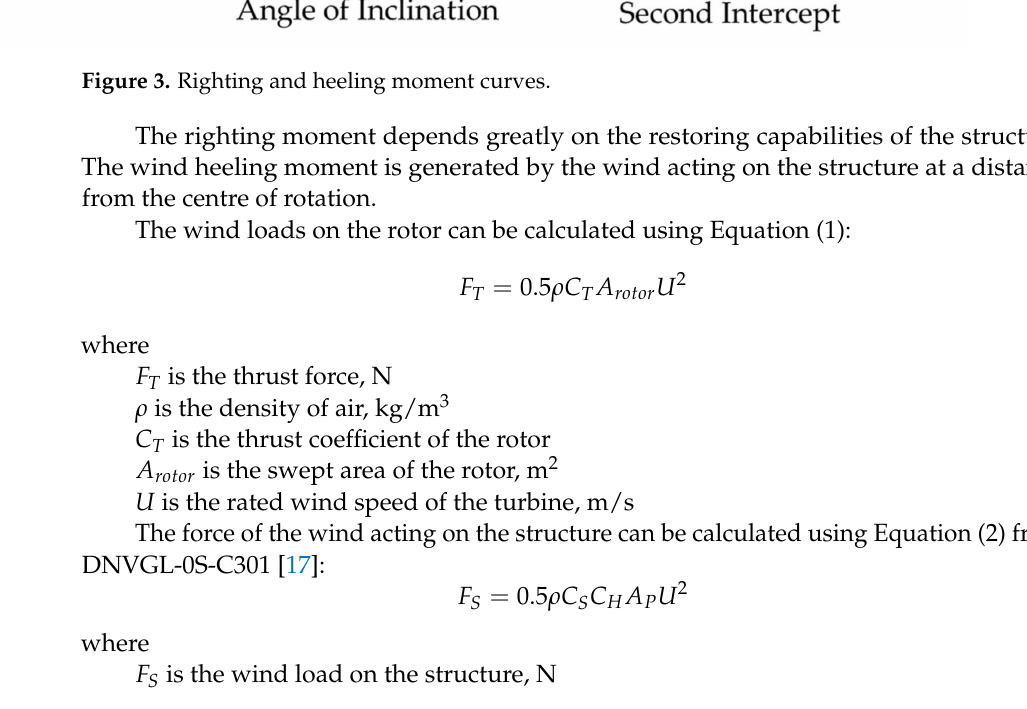
Figure 3. Righting and heeling moment